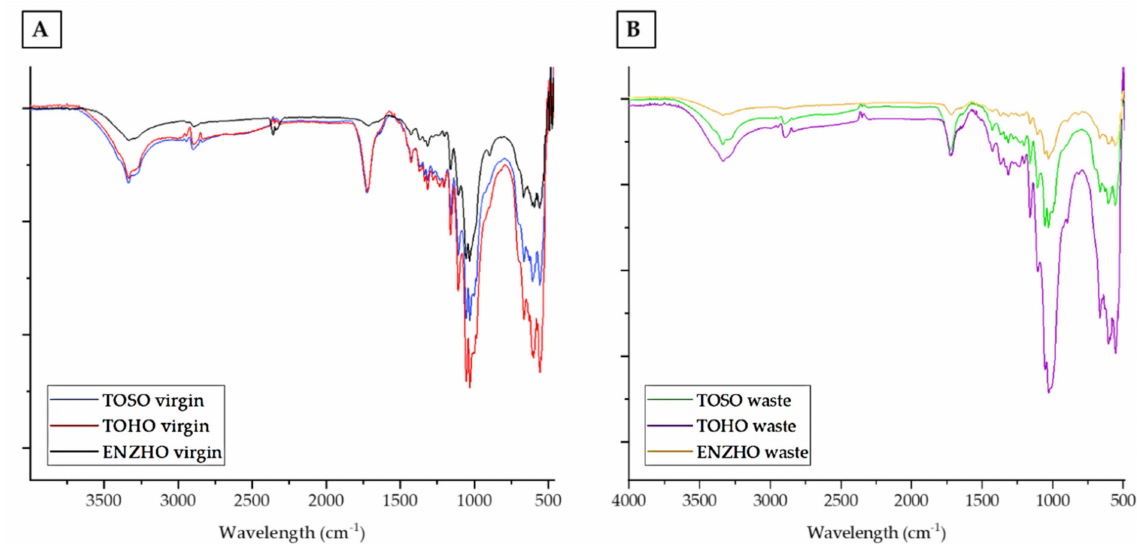
Figure 3. FTIR ATR spectra of virgin ( A ) and waste ( B ) cellulose nanofibers obtained with ENZHO, TOHO, and TOSO